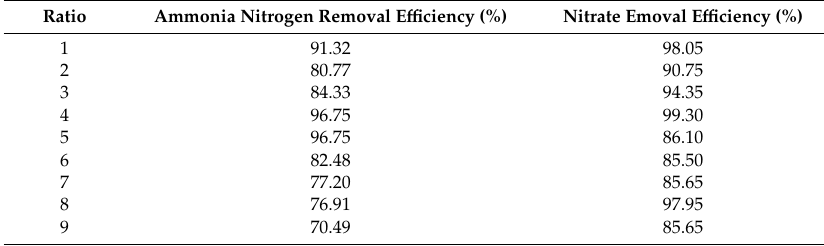
Table 2. The e ff ect of the composite ratio of synthetic microbial community on removal e ffi ciency of ammonia nitrogen and